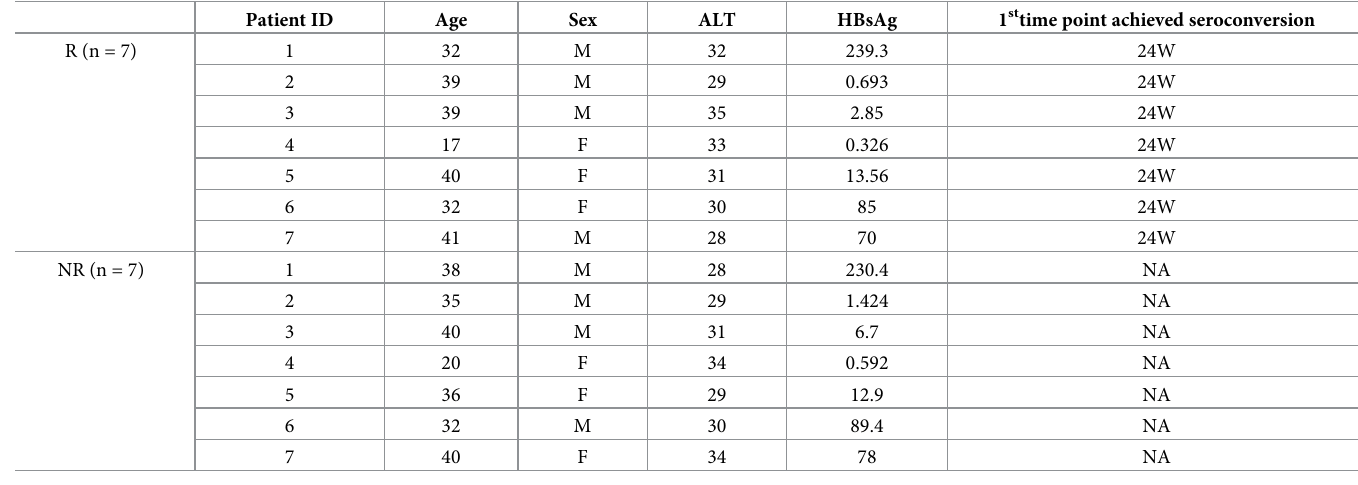
Table 2. Clinical characterization of seven patients who achieved HBsAg seroconversion at 24 weeks, and seven age/sex/HBsAg level at baseline -matched NR cases. Patient